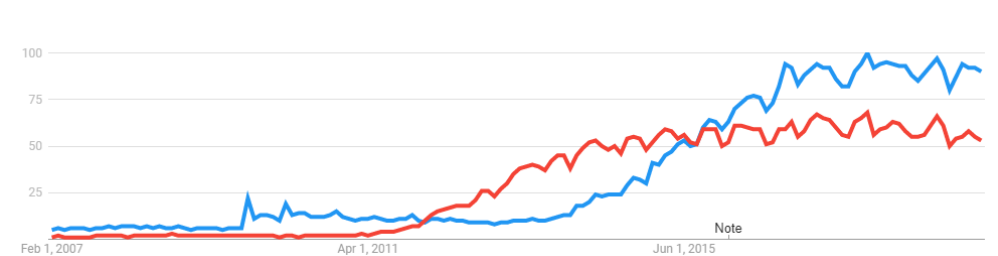
Figure 2. Trends in the availability of web-resources related to the terms ’big data’ (red) and ’IoT’ (blue) since 2007. Values on the vertical axis represent the search interest, expressed between 0 and 100 where the maximum search interest is set to 100. Source: Google